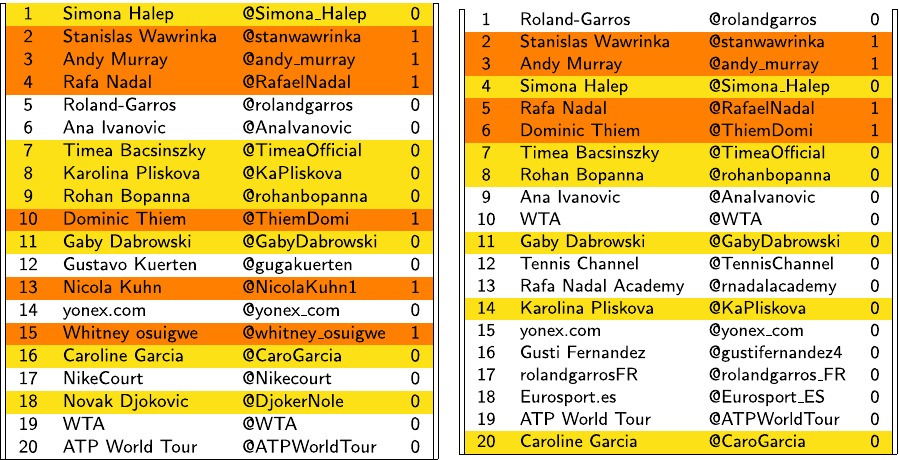
Relevant daily players are highlighted orange. Accounts of players who did not play on this day are highlighted yellow